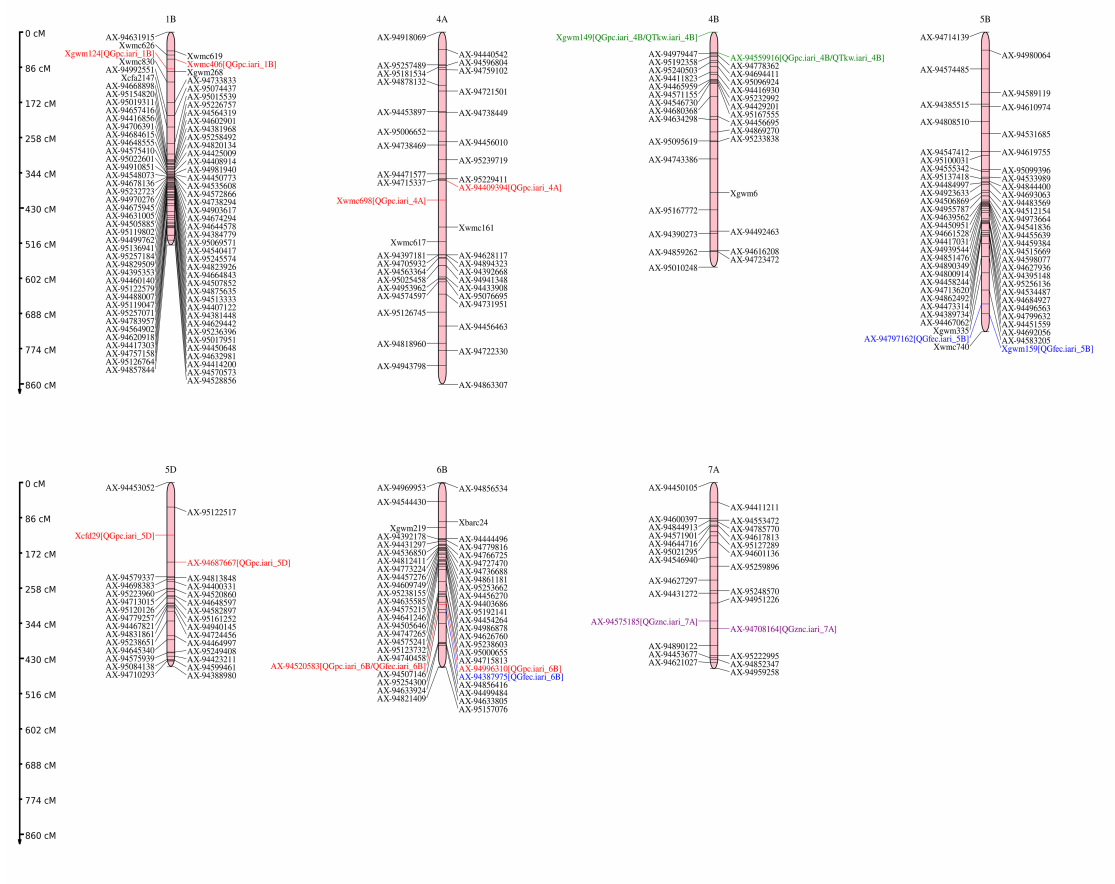
Figure 5. QTL positions identified in A, B, and D subgenomes of RILs derived from HD2932 × synthetic 46. Blue colour indicates QTLs for GFeC; purple colour indicates QTLs for GZnC; red colour indicates QTLs for grain GPC; green colour indicates QTLs for